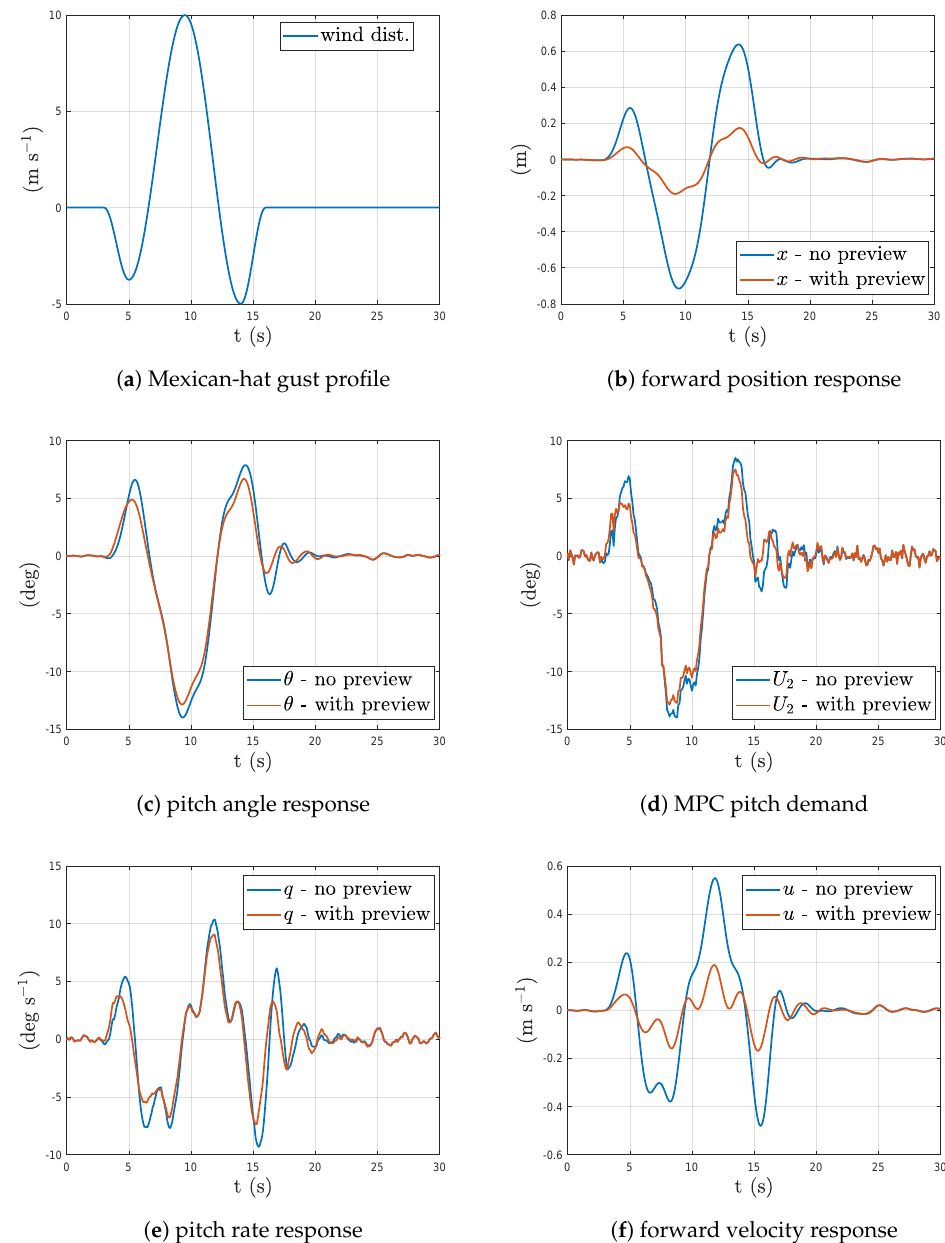
Figure 9. Non-linear aircraft simulation response with and without wind preview control to a Mexican-hat shaped gust profile. One second wind